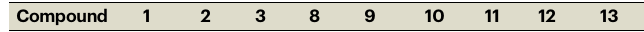
Table 2 | Characteristic times for the single exponential decay of each compound that emits visible light Compound Forthese measurements, λ ex =337nm,and λ em =620nm. Thestandard deviationofreported lifetimes is+/ − 0.22%basedon5 measurements ofa single compound.